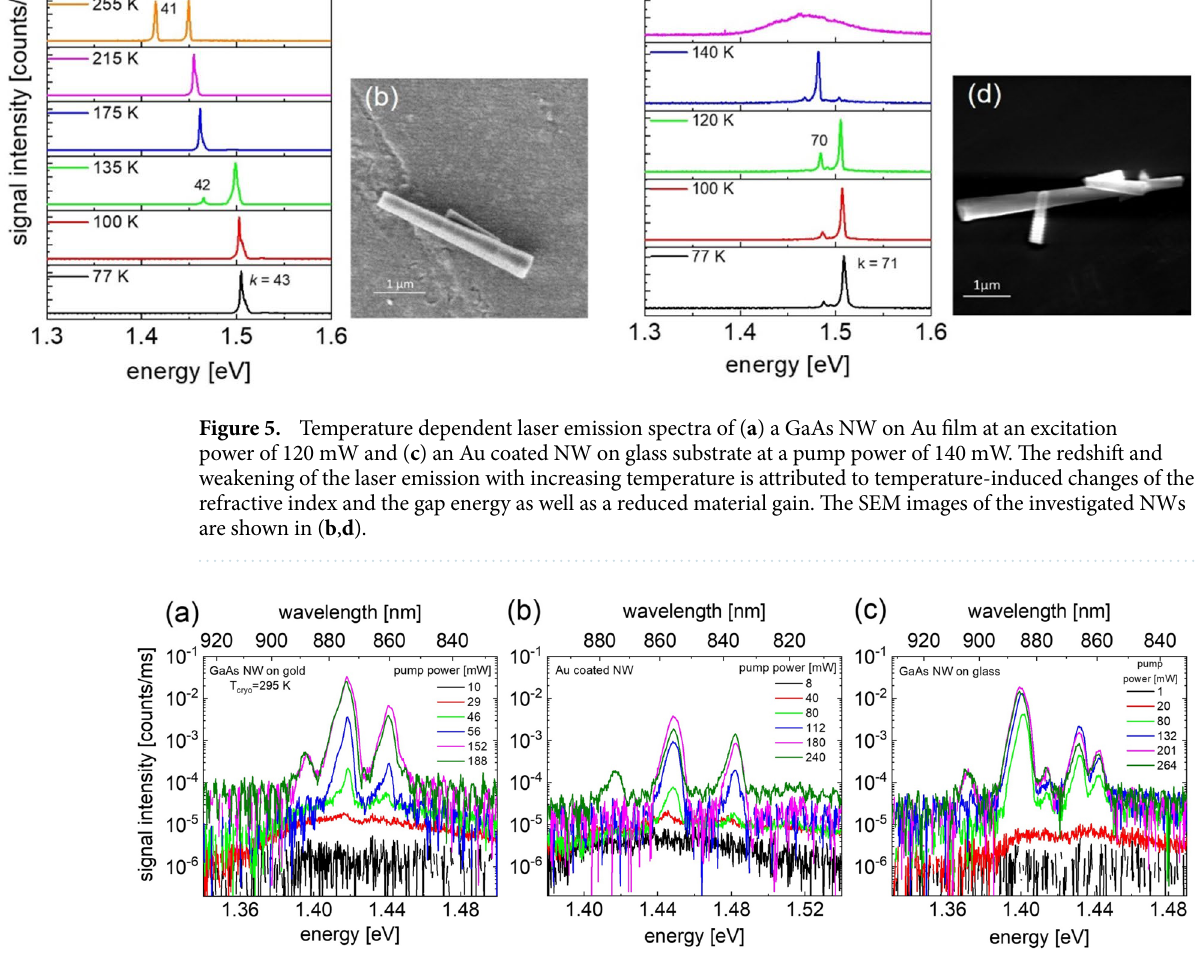
Figure 6. Pump power dependent lasing. ( a ) Spectra at T cryo = 295 K of a NW on Au film ( b ) an Au coated GaAs NW on glass and, ( c ) GaAs NW on glass at λ p = 720